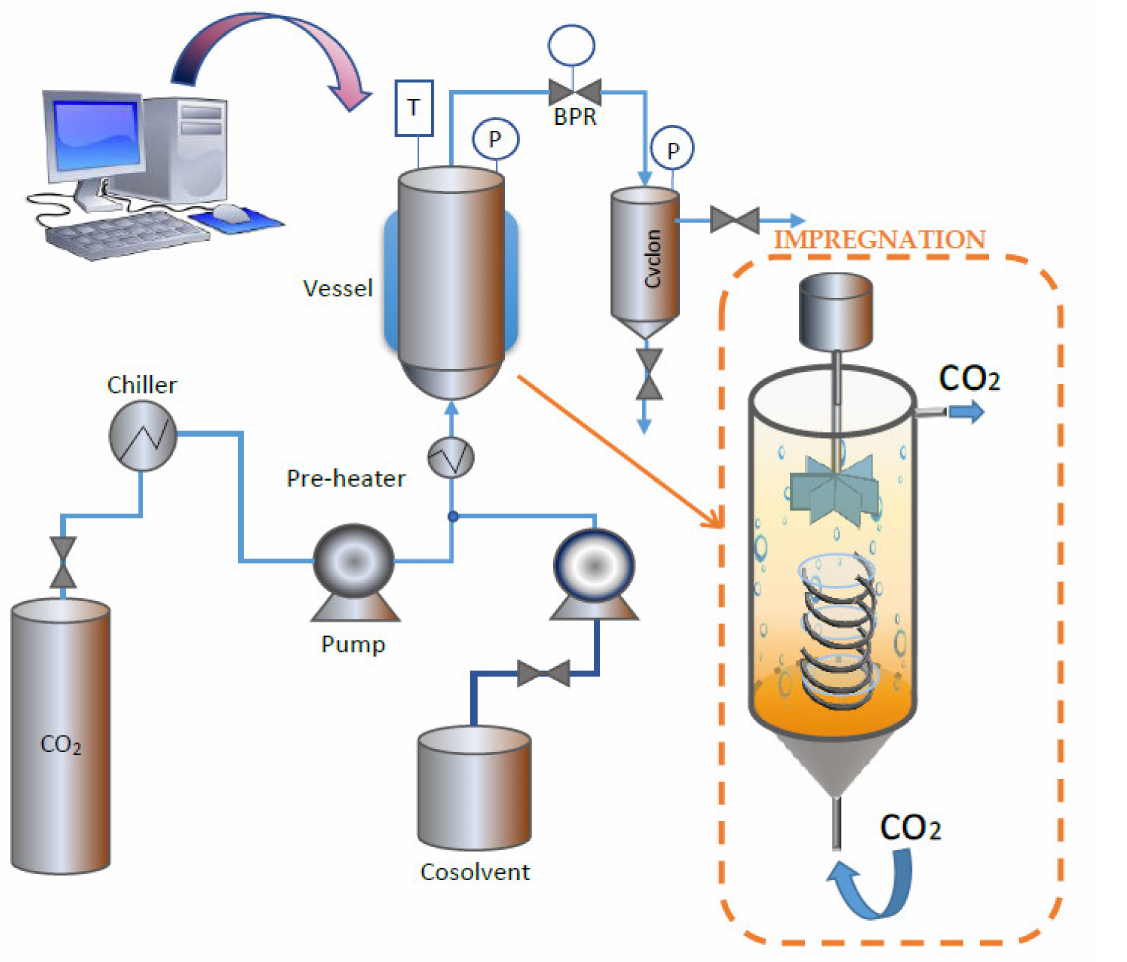
Figure 2. High-pressure equipment used for the extraction and impregnation